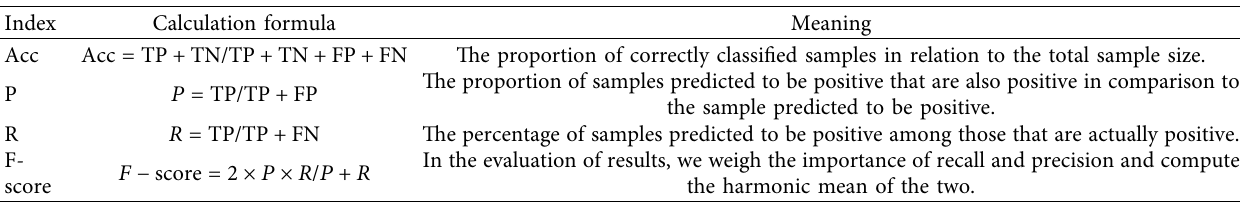
Table 2: Description of evaluation